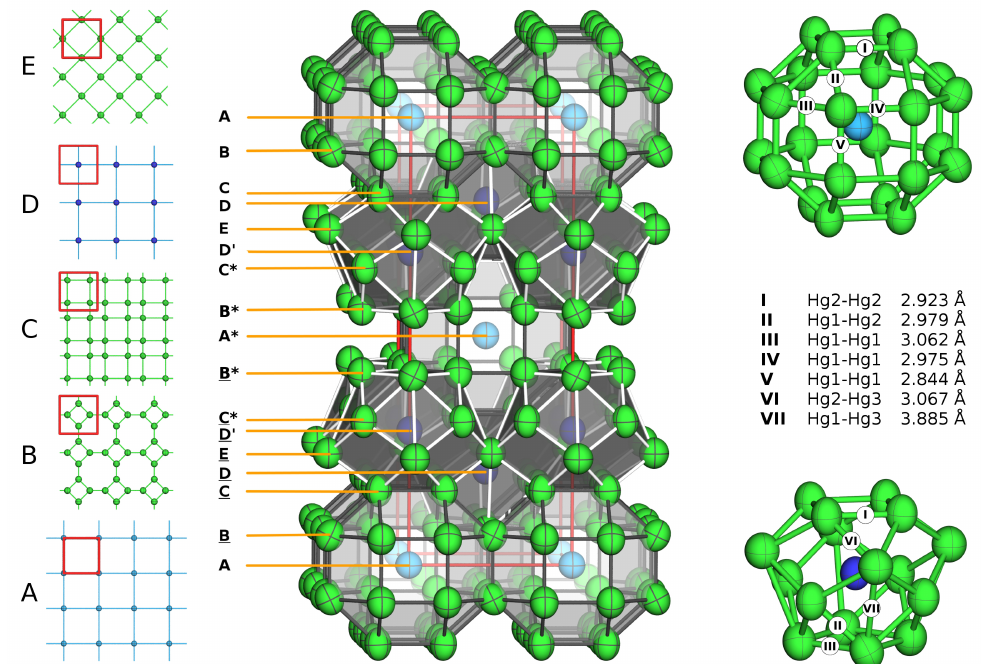
Figure 1. Crystal structure of CsNa 2 Hg 18 . Center: unit cell with polyhedra representation for Cs1 and Na1. Hg: green, Cs: light blue, Na: dark blue. Polyhedra around Cs1 are drawn in light grey, and polyhedra around Na1 in dark grey. The crystallographic c -axis points upwards; the unit cell is marked in red. For all atoms, ellipsoids are shown on a 99% probability level. Left: Net representation with net A (Cs atoms) at z = 0, net B (Hg1 atoms) at z ≈ 0.07, net C (Hg2 atoms) at z ≈ 0.17, net D (Na atoms) at z ≈ 0.20 and net E (Hg3 atoms) at z = 1/4. The stacking sequence marked next to the unit cell is coded with nets X and X’ being related by rotation around the c axis by 45 ◦ , X and X* related by the body centring and X and X related by the horizontal mirror plane at height z = 1/2. Right: coordination polyhedra around Cs1 (top) and around Na1